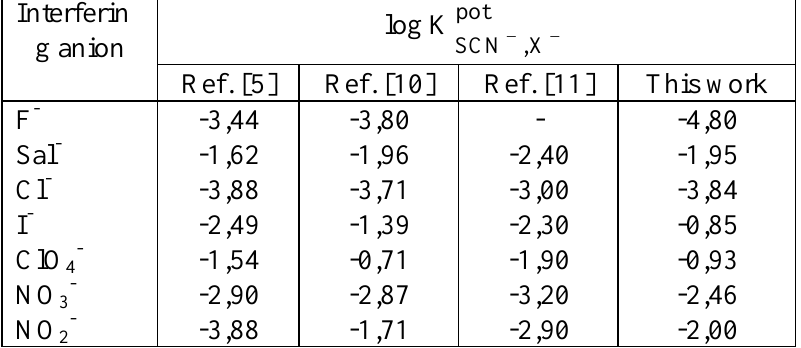
Table 1 . Selectivity coefficients for different thiocyanate-selective electrodes